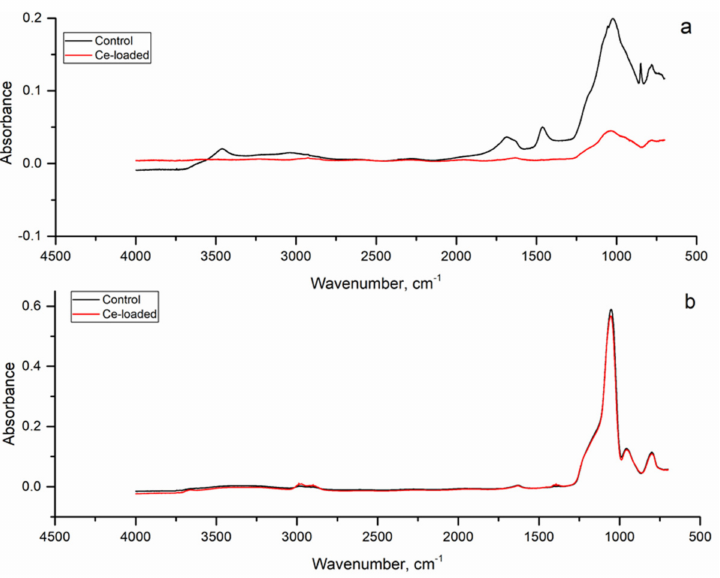
Figure 5. FTIR spectra of ( a ) silica SBA-15 and ( b ) titanosilicate